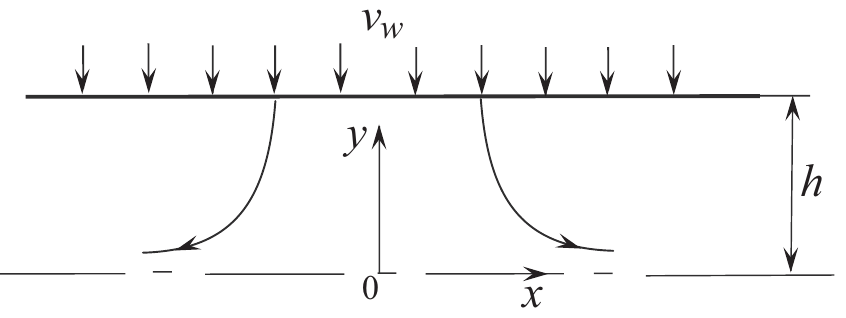
Figure 1. Flow induced by fluid injection.